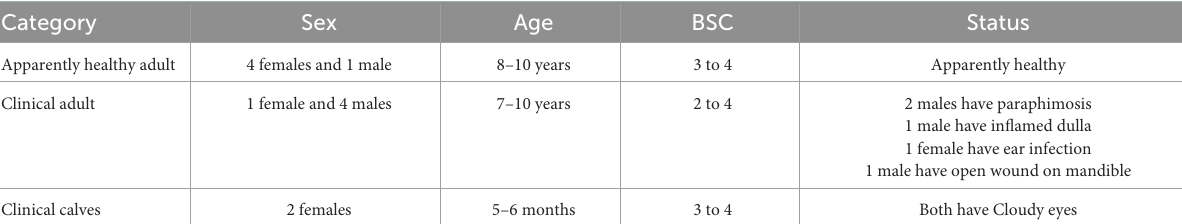
TABLE 1 Details of participated